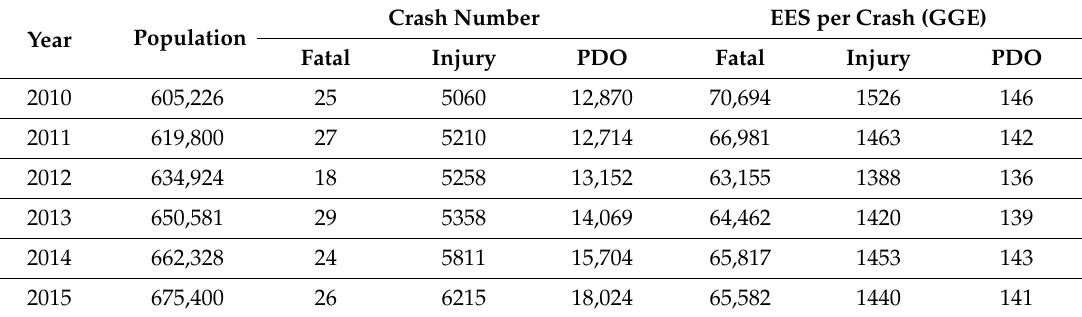
Table 8. EES analysis for Washington,